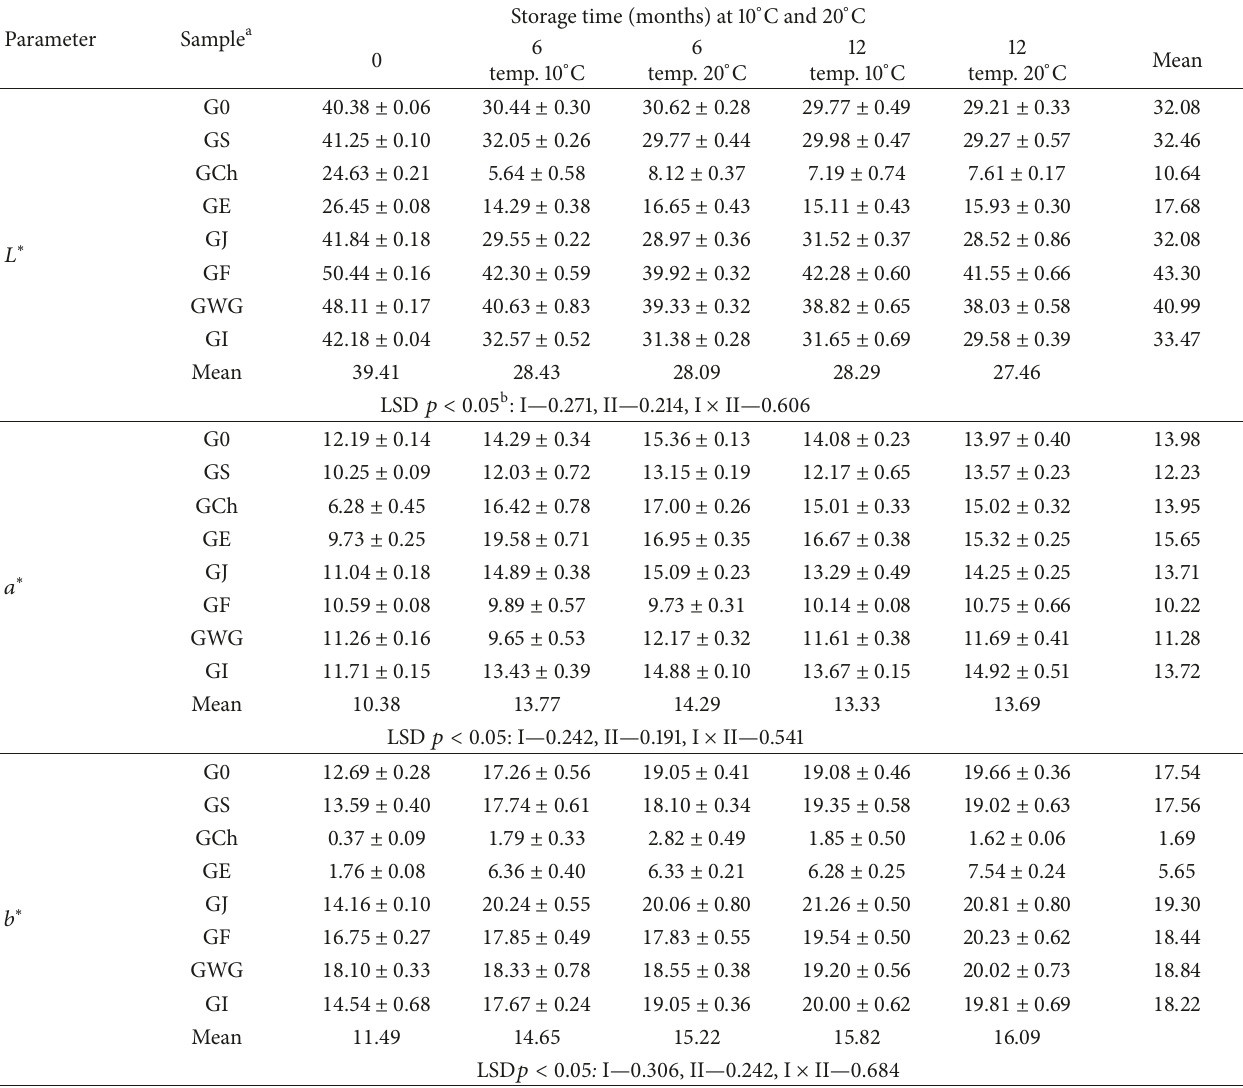
Table 3: Changes in color parameters (𝐿 ∗ ,𝑎 ∗ , and 𝑏 ∗ ) of gooseberry jams during storage in 10 ∘ C and 20 ∘ C.